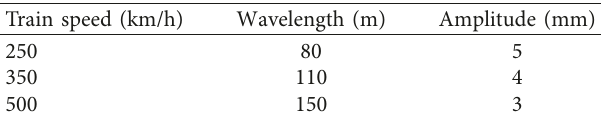
Table 3: Sensitive long wavelength and its corresponding man- agement amplitude.